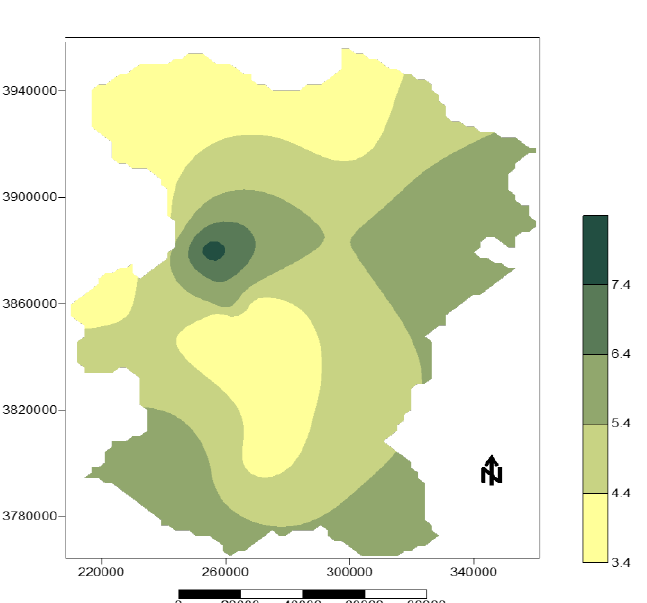
Fig. 7. Zoning of vegetation classification of Gamasyab and Gharechay